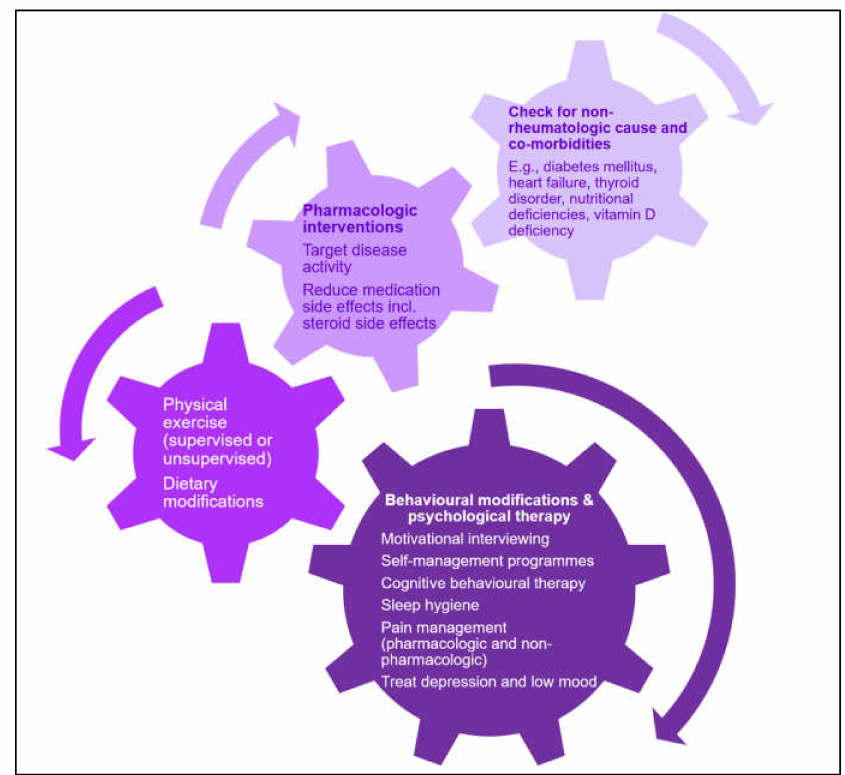
Figure 3. Common themes in the management of fatigue in rheumatoid arthritis and systemic lupus erythematosus